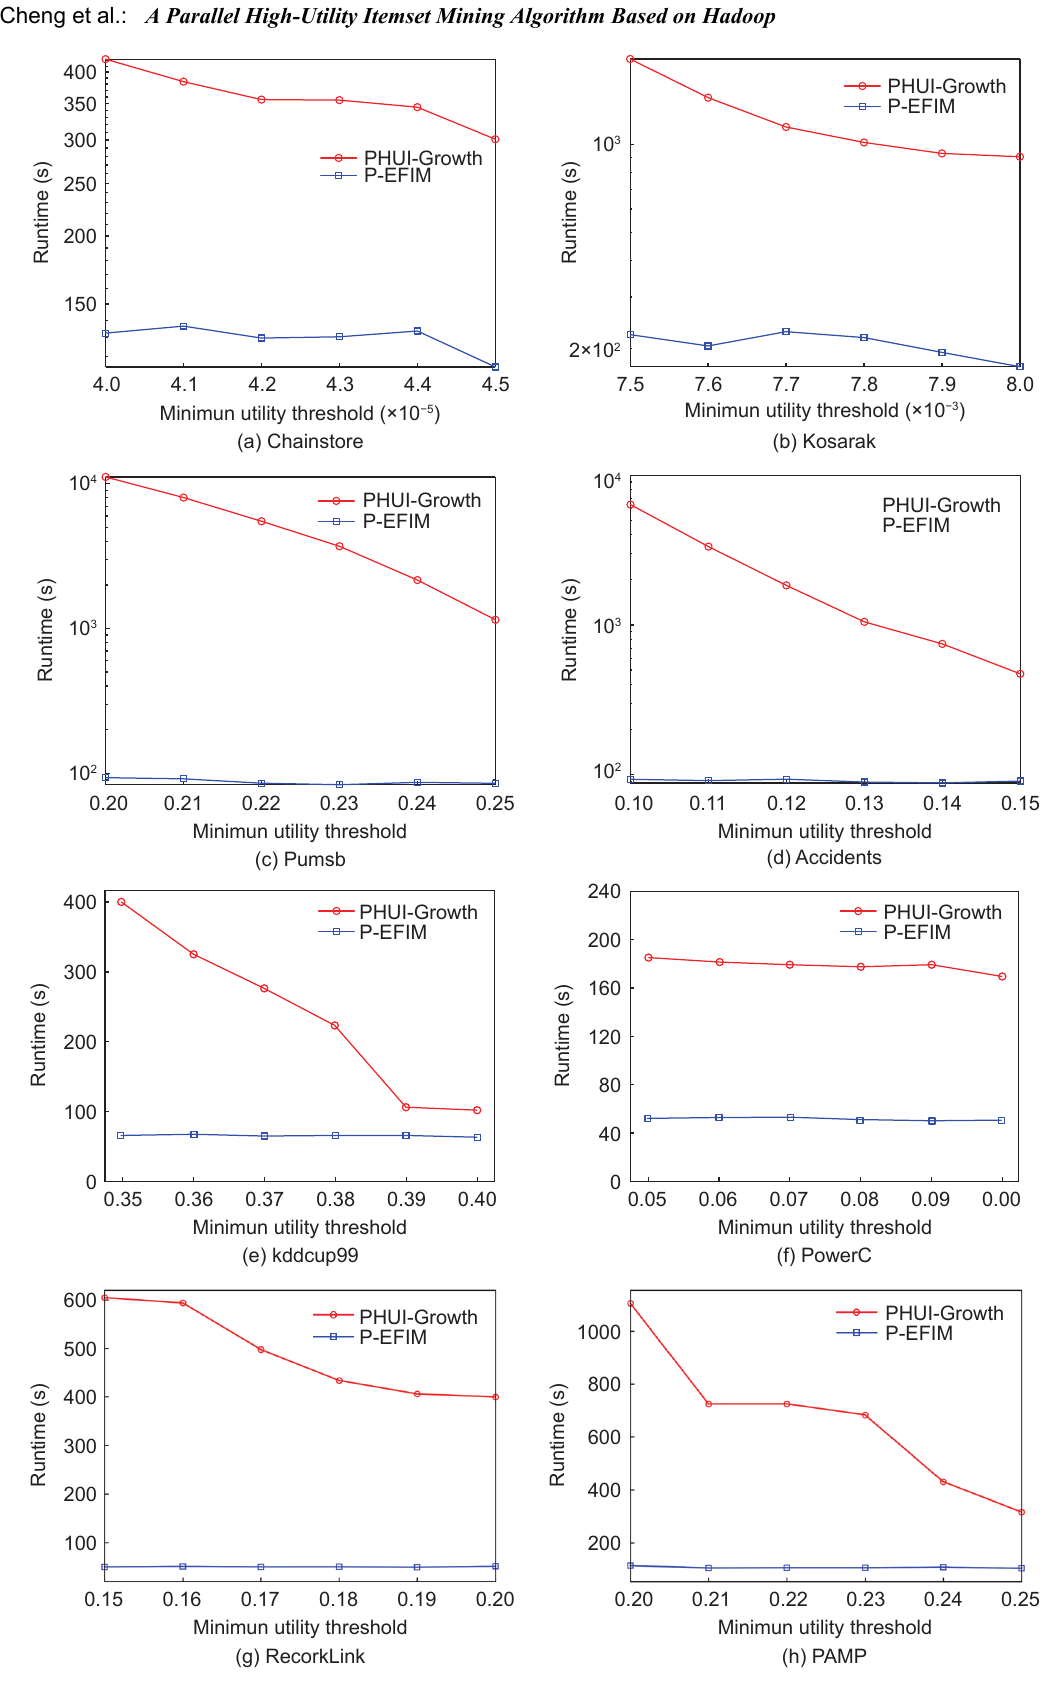
Fig. 5 Runtime values of the two parallel algorithms with Reduce =